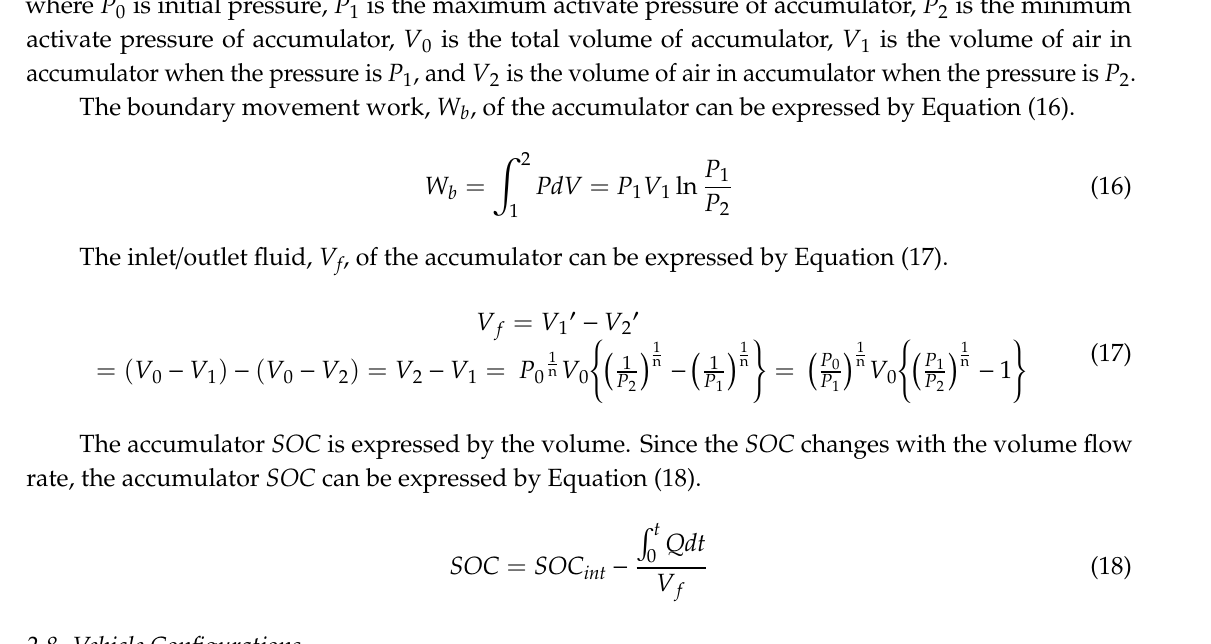
Figure 5. Hydraulic electric hybrid vehicle (HEHV) configuration. 3. Optimization Control Strategy In this study, genetic algorithm (GA) was applied as the optimization function. The rule-based control was taken as the energy management strategy of HEHV first, and the simulation result was compared with the pure-electric-vehicle model. Then, the selected optimization approach was implemented for global optimization. From those results, together with a rule-based control approach, the optimal electricity economic performance was obtained. The global optimization calculation was made by genetic algorithm. The objective of GA optimization was to minimize electricity consumption, and the objective function was set to be the reciprocal of the lithium ion battery’s state of charge, SOL Li, as shown in Equation (19). The setting of objective function in GA could correspond to the fitness function, as shown in Equation (20). Parameters of GA set in this study are shown in Table 1. cost = min (1/ ∑ ( SOC Li))